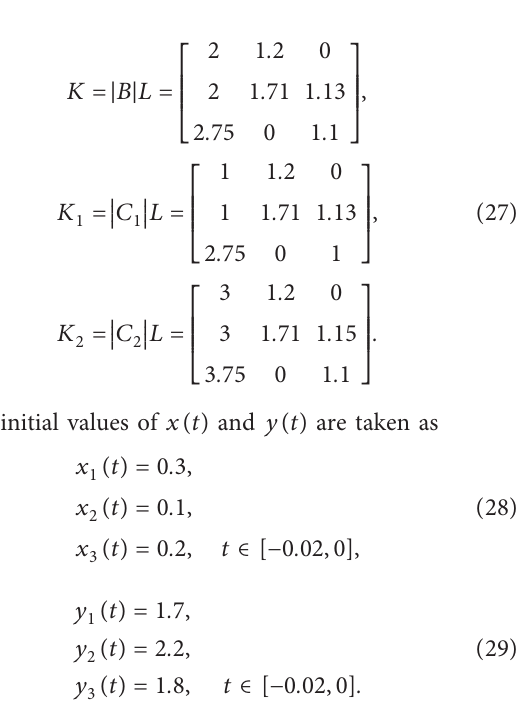
( t ) under the different fractional orders α i